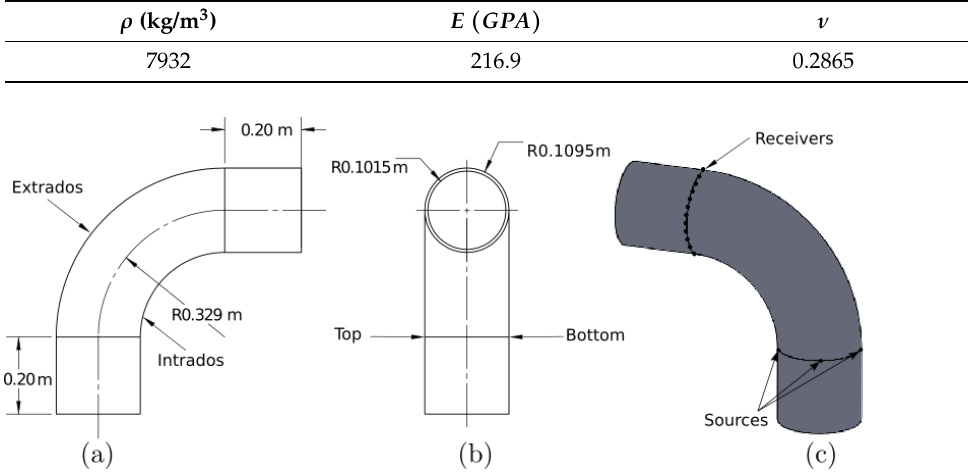
Figure 4. Schematic of the pipe bend. ( a ) Top view, ( b ) lateral view, and ( c ) isometric view of the simulated pipe bend.